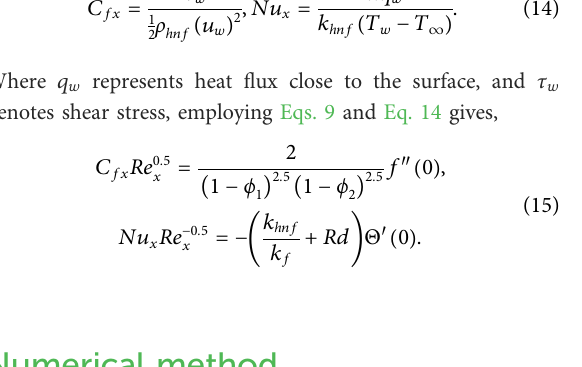
(cid:2) 0 . 1 , Pr (cid:2) 6 . i